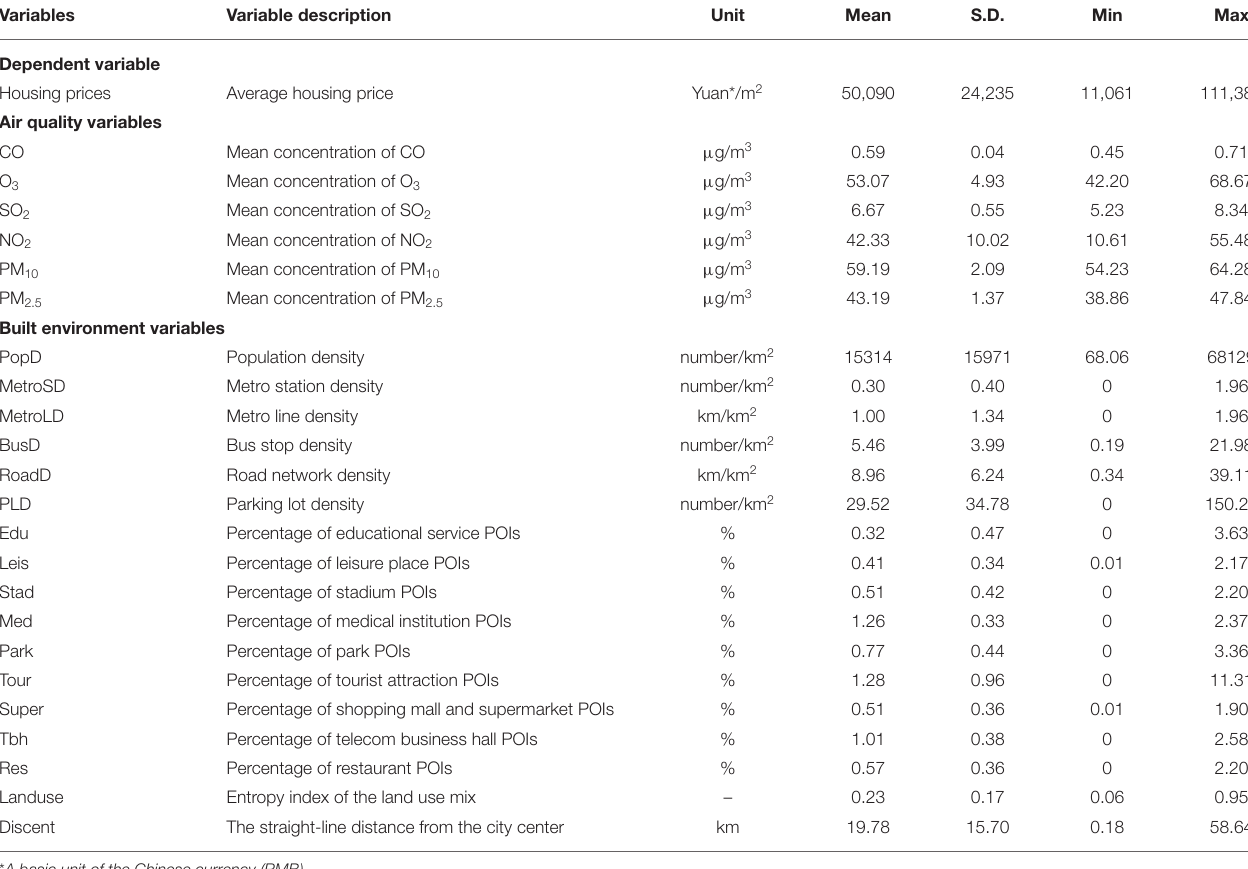
TABLE 2 | Variable definitions and